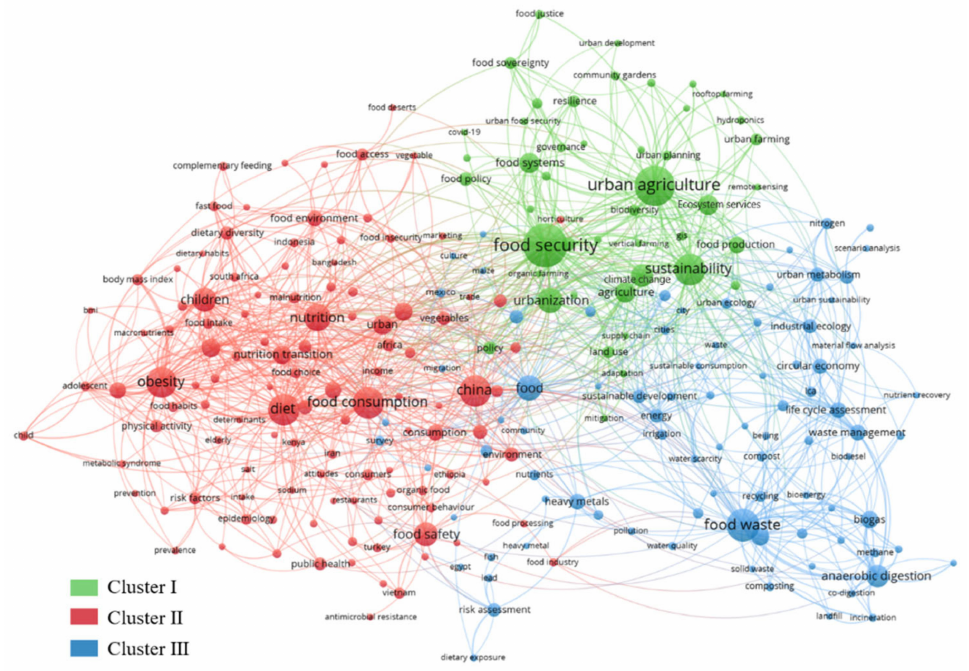
Figure 7. Authors’ keyword cluster